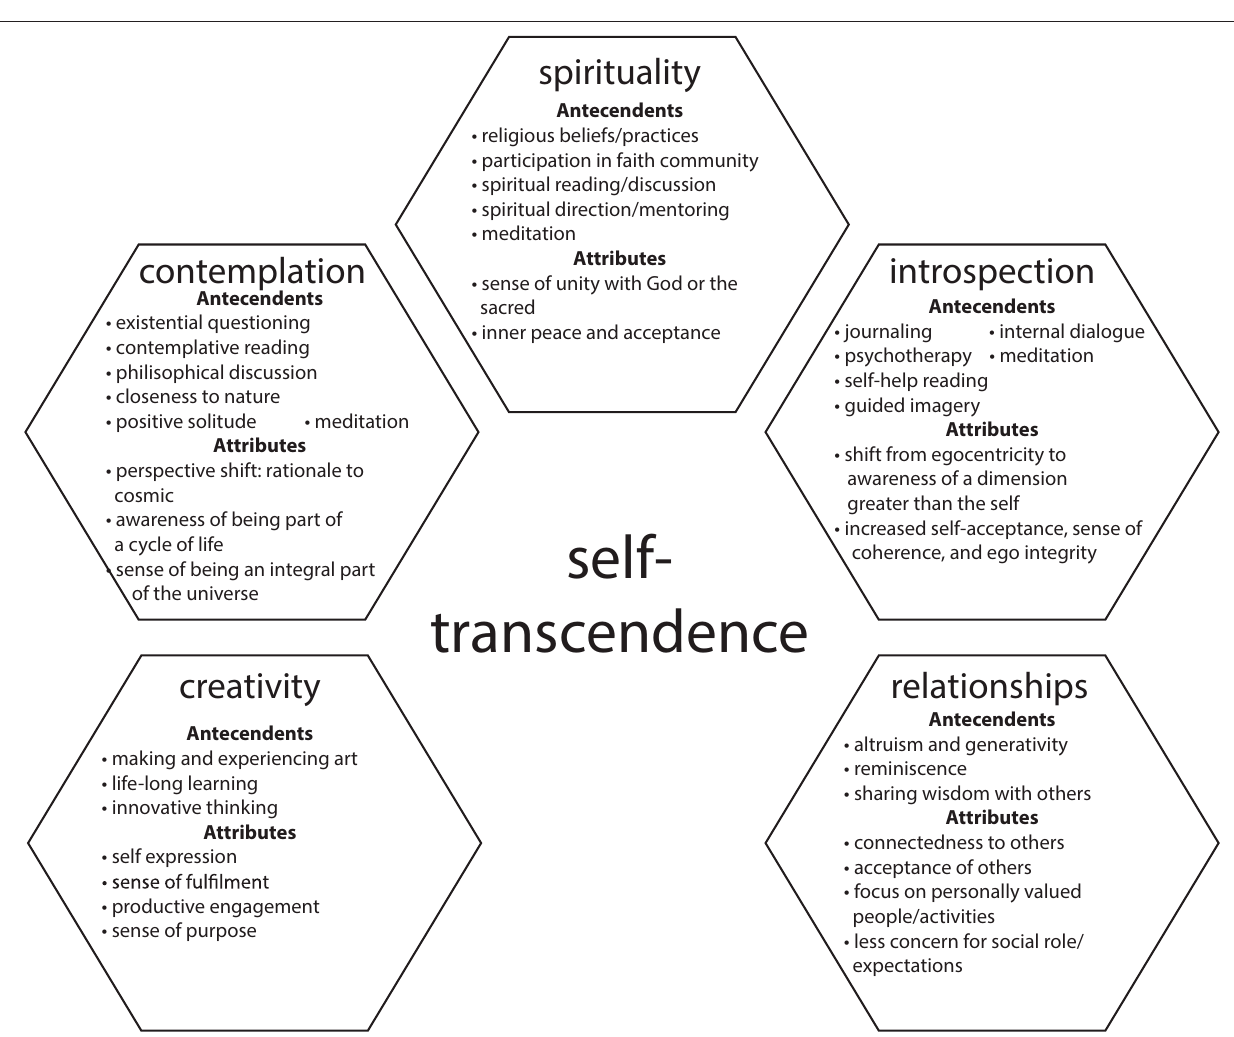
during states of lucidity in sleep and absorption in meditation (Thompson,